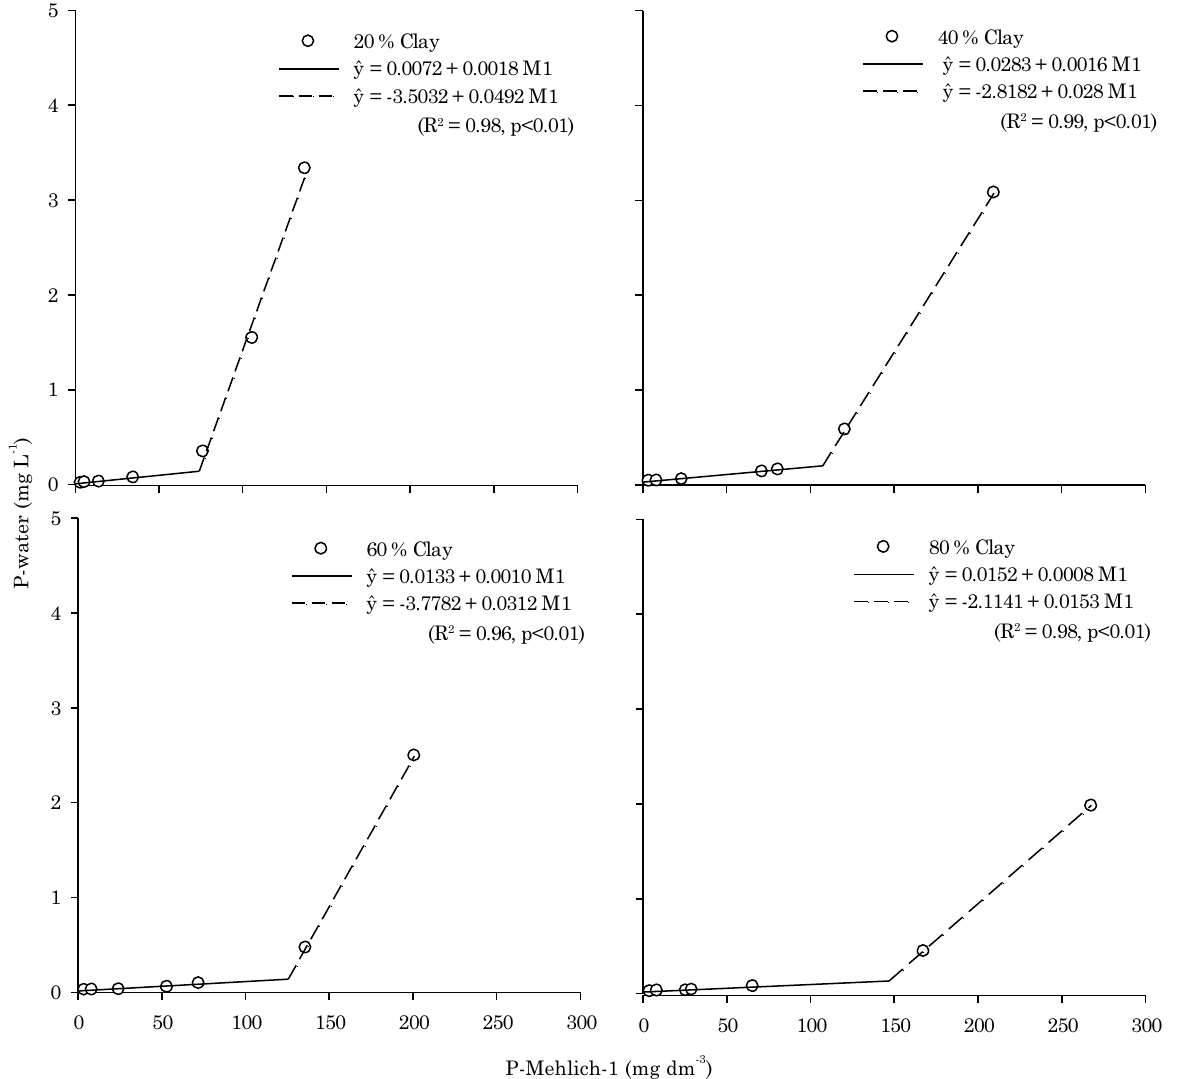
Figure 4. Phosphorus-water and P levels assessed by Mehlich-1 (M1) in soils with different percentages of clay following incubation for 20 days with varying P rates. The intersection of the equations is the change-point